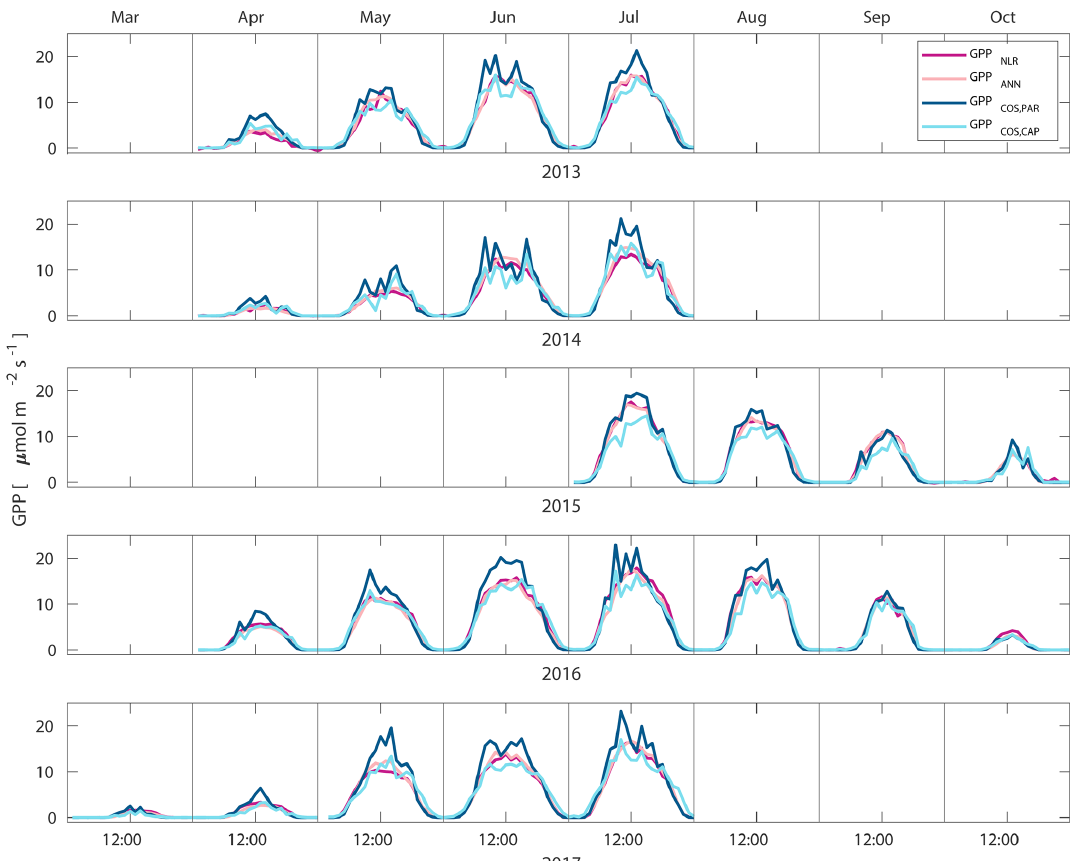
Figure 2. Median diurnal variation of GPP partitioned using a combined nighttime–daytime method (GPP NLR , purple line), GPP from artificial neural networks (GPP ANN , pink line), GPP from COS flux measurements with LRU determined according to Kooijmans et al. (2019) (GPP COS,PAR , dark blue line), and GPP from COS flux measurements using a new approach for LRU (Sect. 2.3.4, GPP COS,CAP , light blue line) in different months during the measurement period 2013–2017. Averaging was done to the same data points, and only months with more than 55% of data coverage were